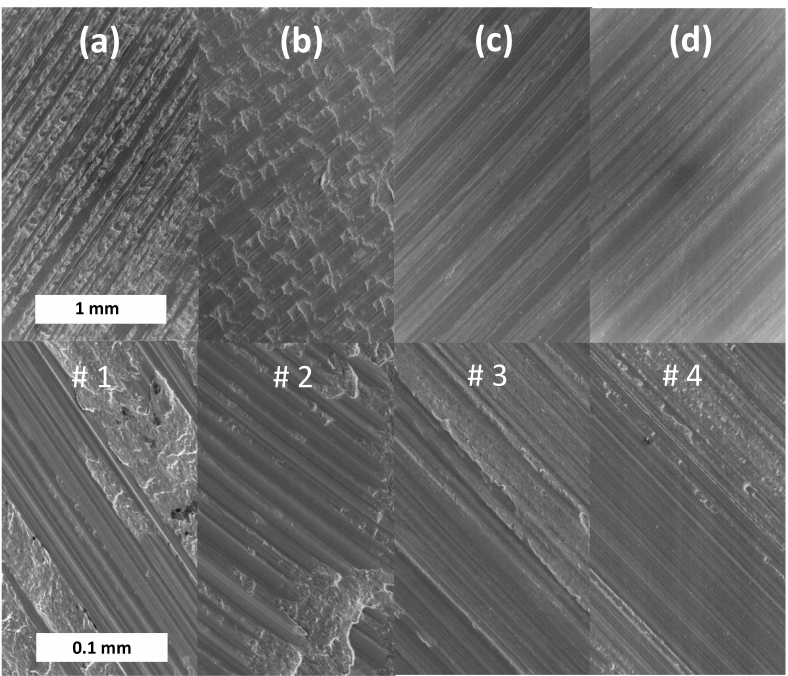
Figure 23. ( a – d ) Scanning electron microscopy images of the surfaces machined by the procedures # 1–4 according to Table 4. The upper row shows a low, the lower row a high resolution of the surface